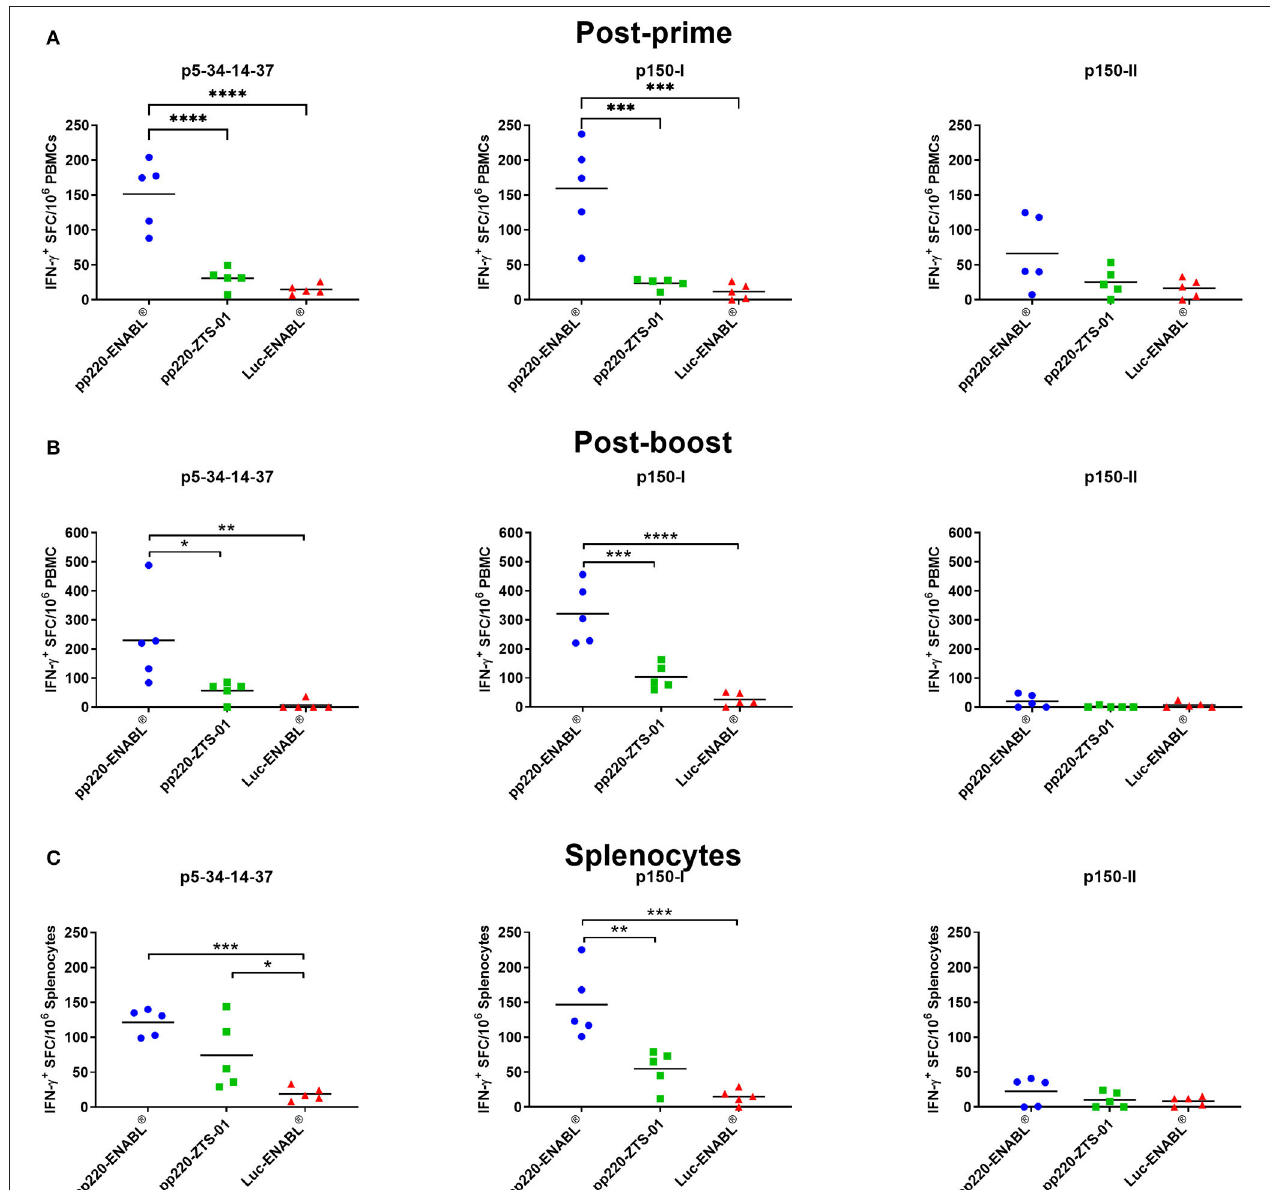
FIGURE 7 | IFN- γ responses against pp220 antigens. p5-34-14-37, p150-I- and p150-II-specific IFN- γ responses were detected by EliSpot assay using PBMCs from (A) Two weeks post-priming; (B) One-week post-boost; and (C) in splenocytes. Data is presented as Spot Forming Cells (SFC)/10 6 PBMCs or splenocytes. Medium alone served as the negative control, and the data shown is minus media background counts. Mean responses for the groups are denoted by bars, and statistically significant differences between groups are denoted by asterisks (* p < 0.05, ** p < 0.01, *** p < 0.001 and **** p <